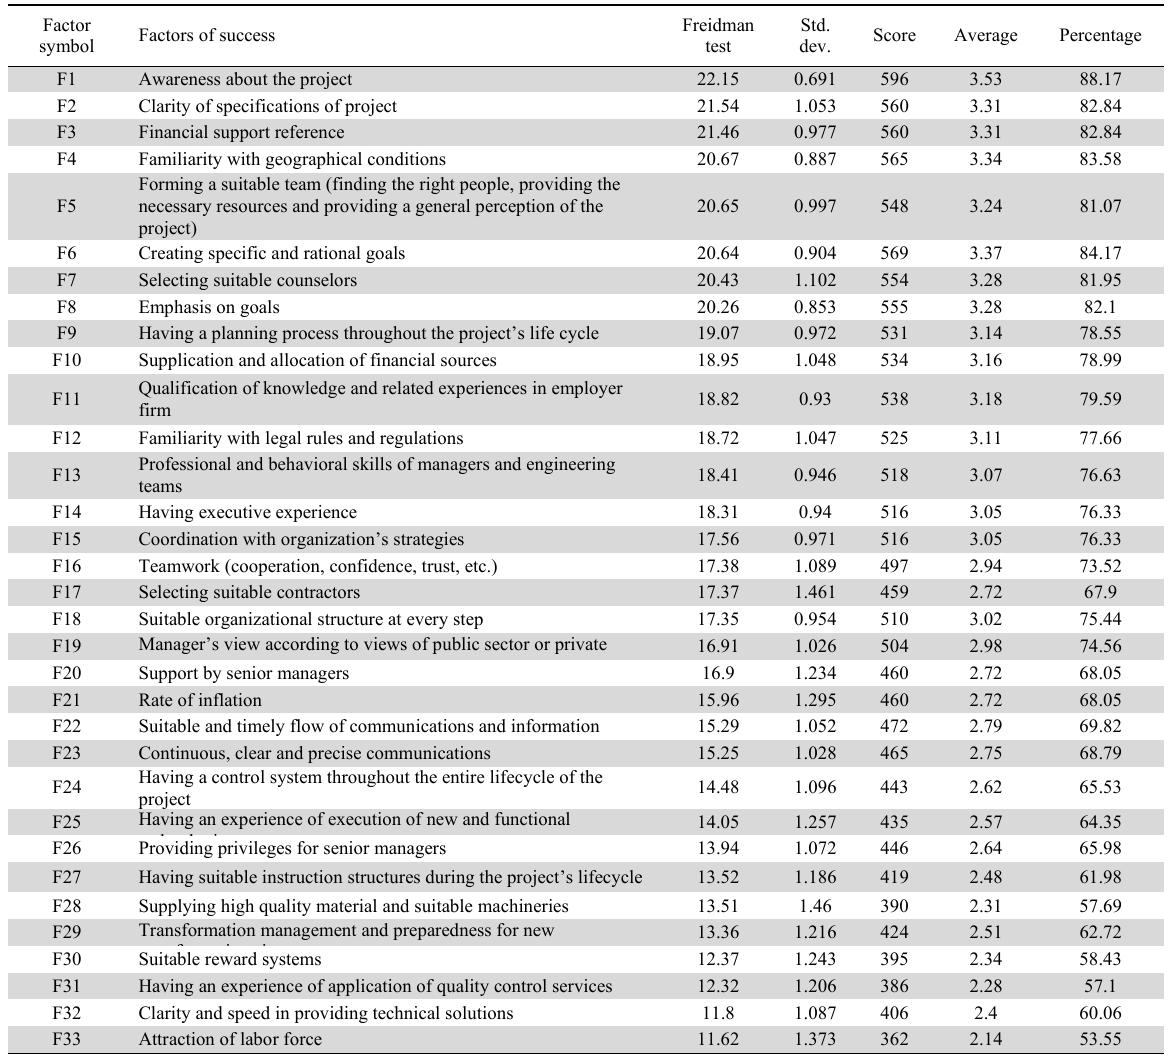
Collected success